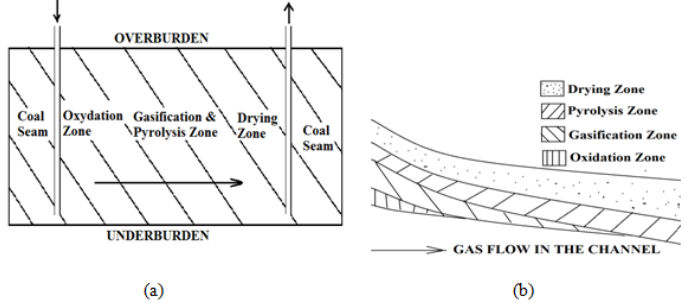
Figure 52. ( a ) Reaction zones along the direction of gas flow; ( b ) Reactions zones surrounding a channel (reproduced from Tsang [74]).